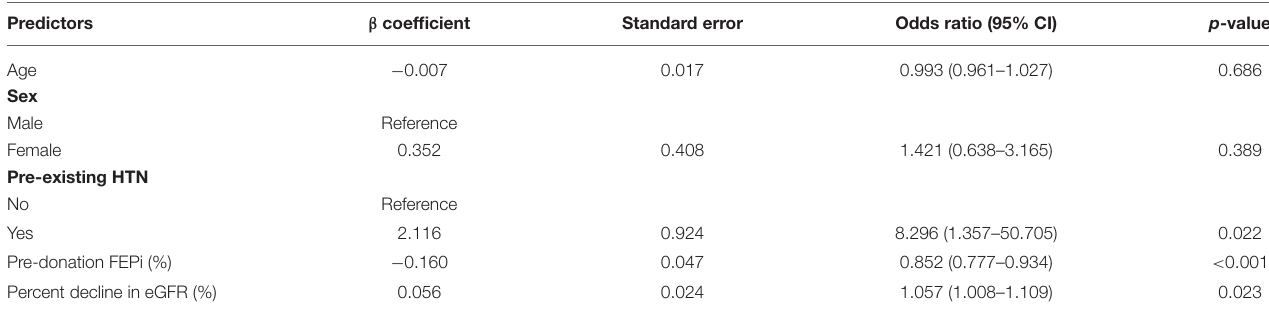
TABLE 4 | Predictors of the alteration of mineral bone metabolism after uni-nephrectomy.